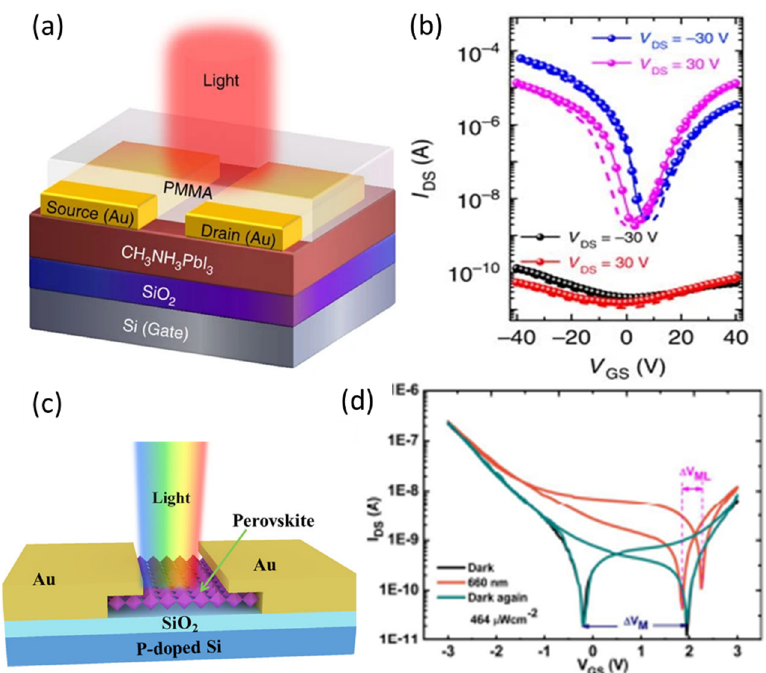
Figure 10. ( a ) Device schematic of CH 3 NH 3 PbI 3 channel-based phototransistor. ( b ) Transfer characteristics of phototransistor in dark (red and black) and in illumination (blue and magenta) [97]. Copyright 2015, Springer Nature. ( c ) Device structure with MAPbI 3 -based photo FET. ( d ) The hysteresis behaviour and ambipolar transfer characteristics of the photo FET in dark (blue), under 660 nm illumination (orange), under dark again (black). Reproduced with permission from [99]. Copyright 2018, American Chemical Society.